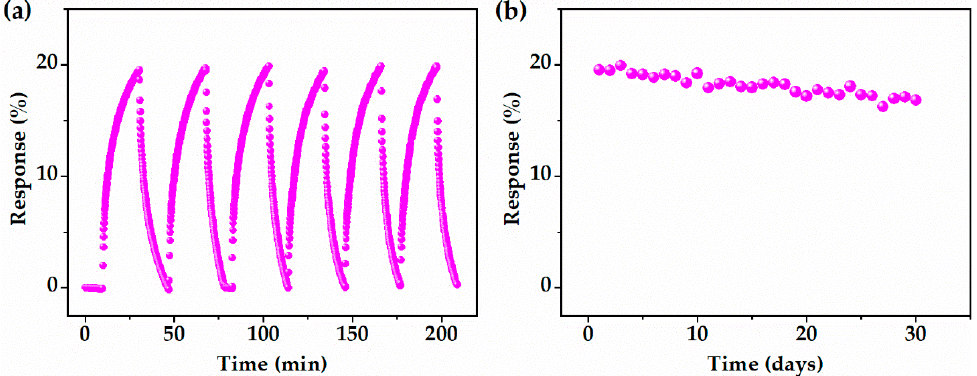
Figure 5. OP-G/G based sensor upon exposure to 500 ppm NH 3 at room temperature: ( a ) The reproducibility and ( b ) long term stability.